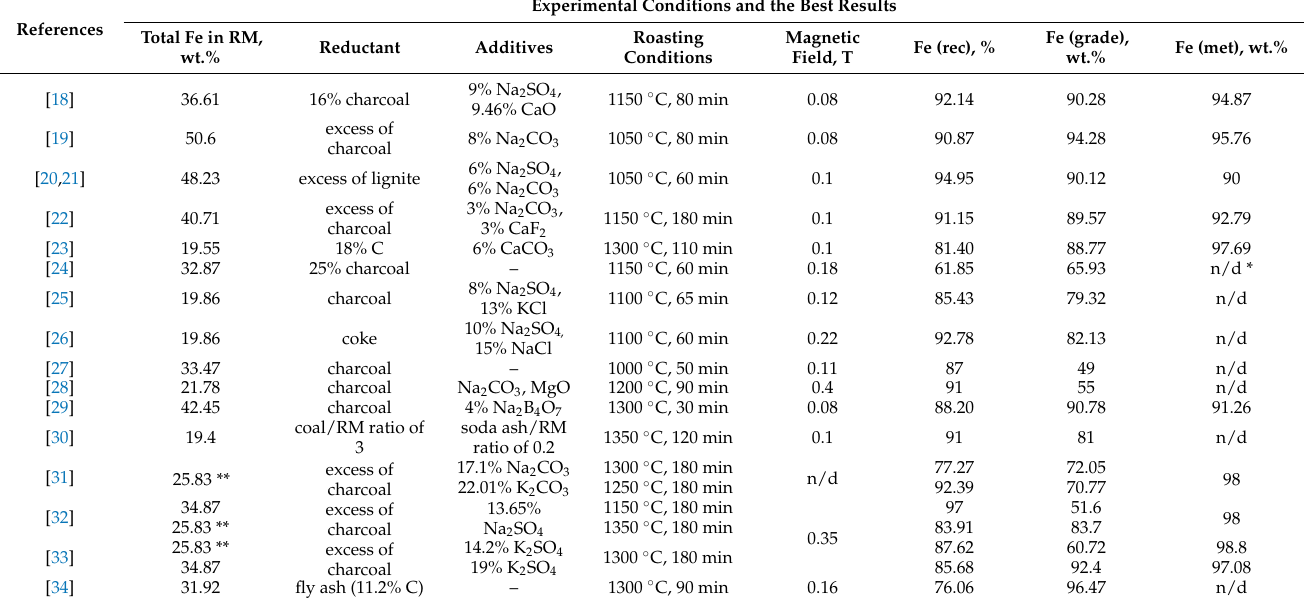
Table 1. Data from various studies on the iron extraction from RM by the reduction roasting–magnetic separation